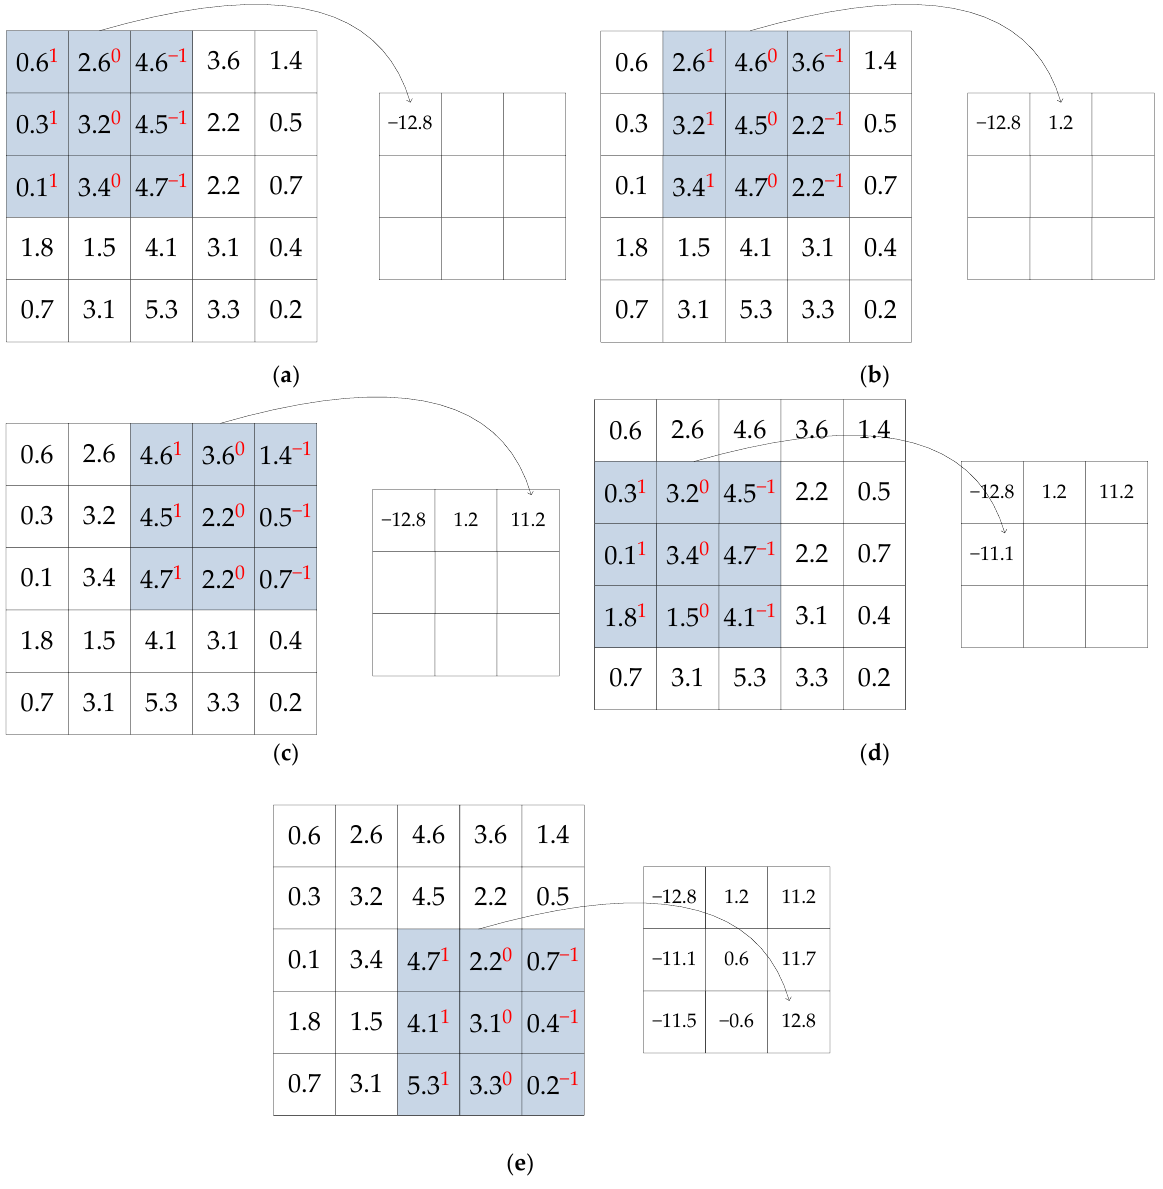
Figure 5. Convolution process with the result of ( a ) the first convolution, ( b ) the second convolution, ( c ) the third convolution, ( d ) the fourth convolution, and ( e ) the last convolution.